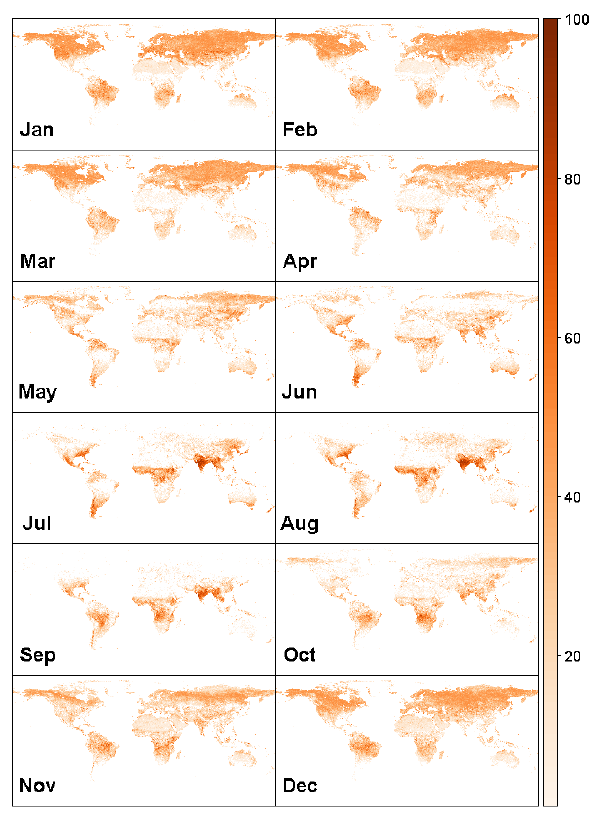
Figure 1. Percentage increase in pixels added (i.e. gaps filled) after applying the temporal filter to Vegetation Index and Phenology Lab version 3